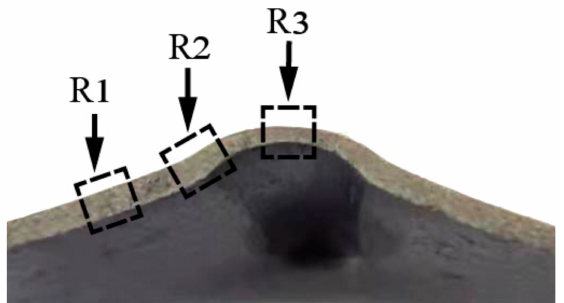
Figure 9. Sketch of specimen positions in the transverse section.